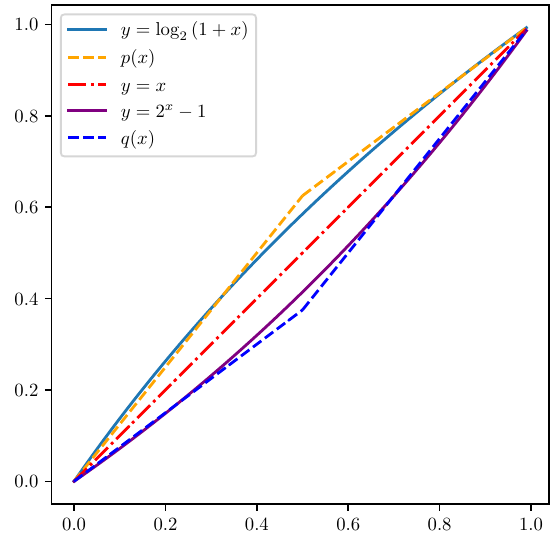
Figure 1. Logarithmic function and its different approximations.